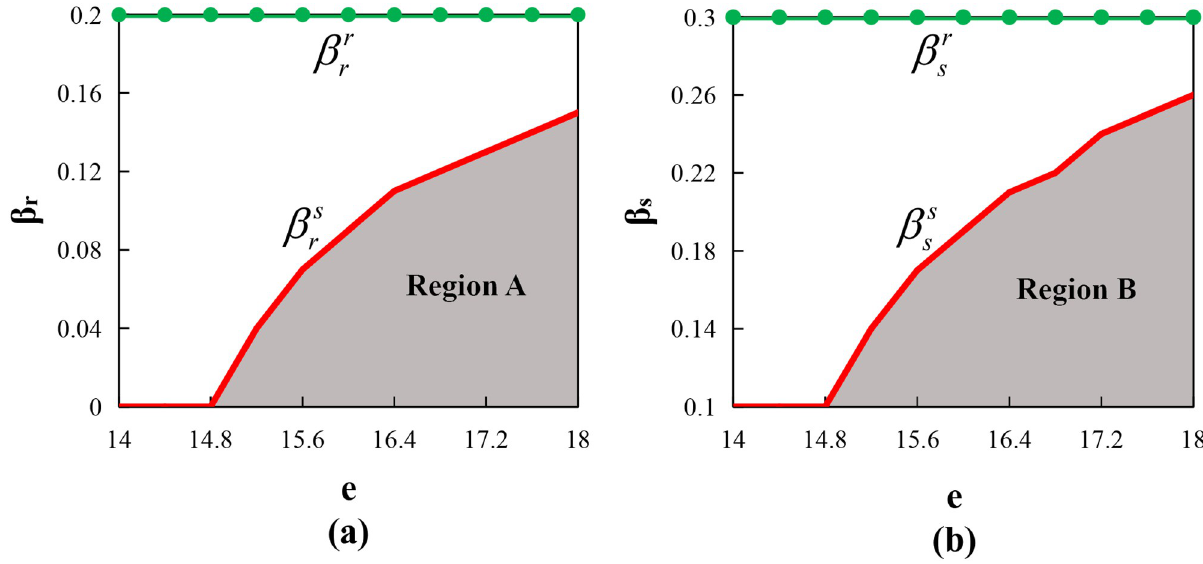
Fig 3. Impact of loss rate on the Pareto